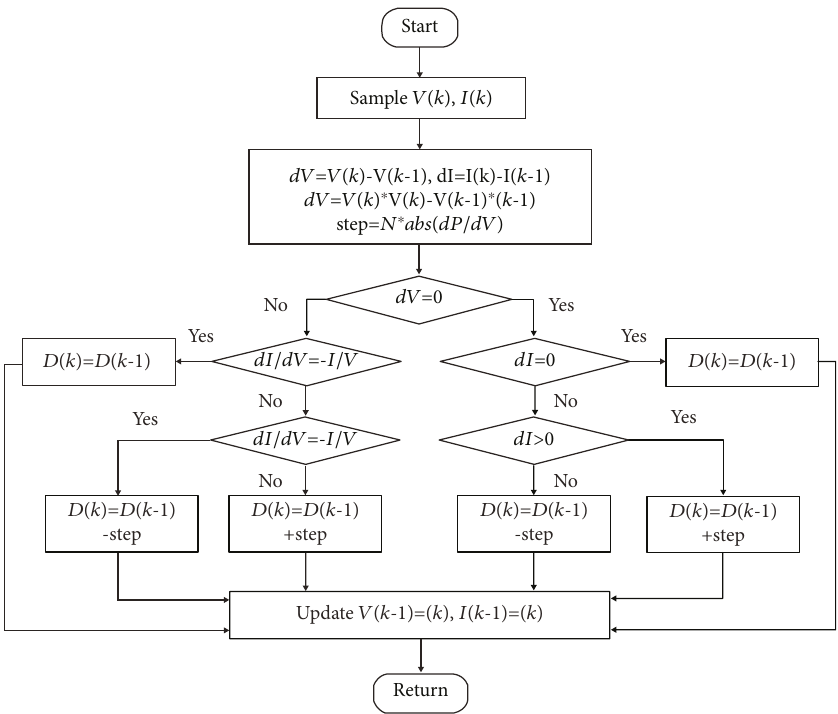
Figure 13: Incremental conductance MPPT fl ow chart.